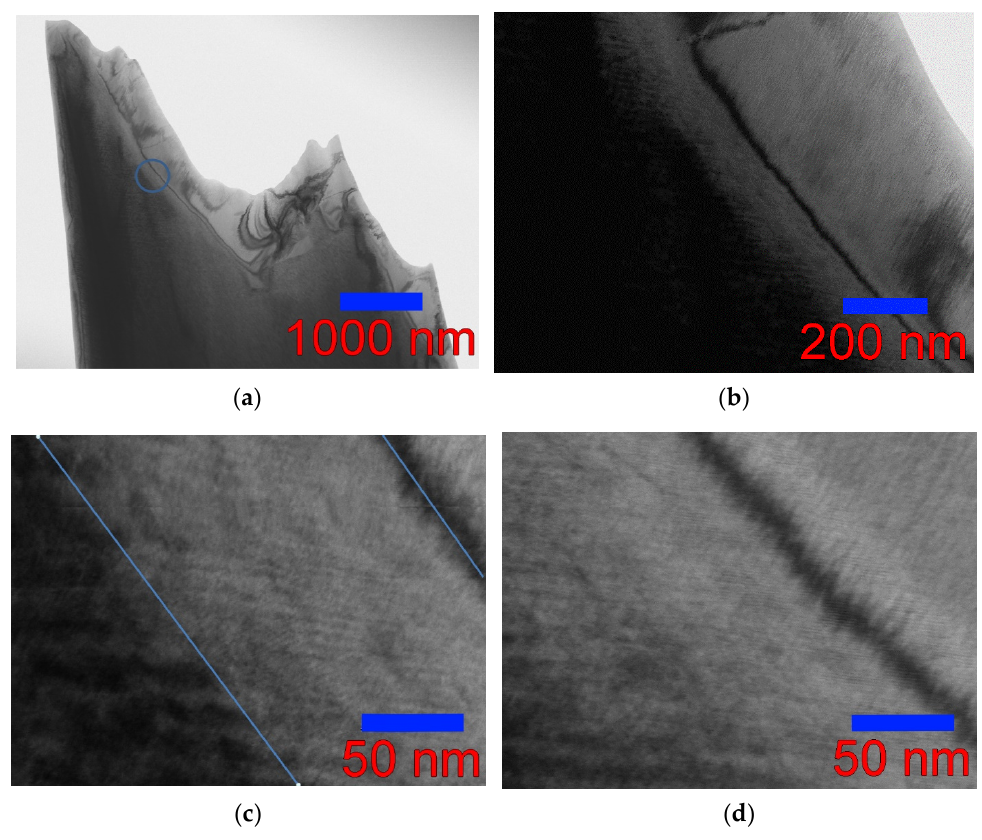
Figure 11. A–M boundary (100 K) at different magnifications (upper right corner—austenite, lower left corner—martensite), bright-field images.